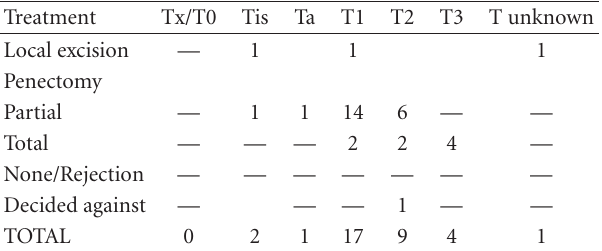
Table 2: Primary treatment according to the Stage of the primary